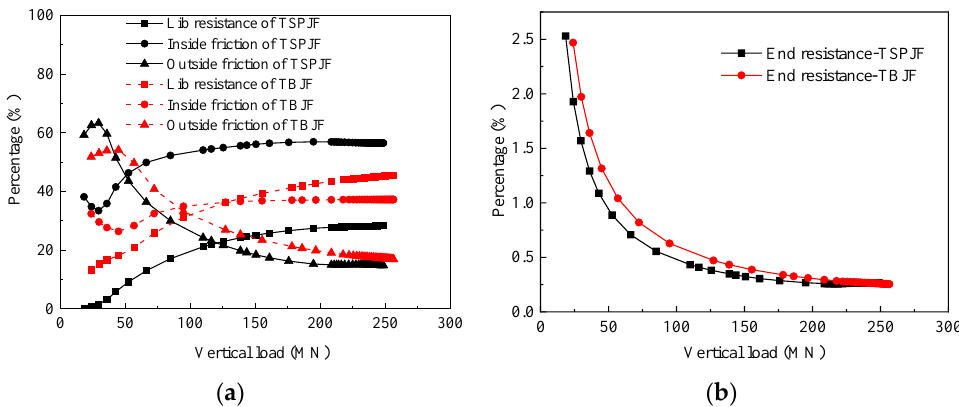
Figure 8. Bearing proportion of each part of the foundations at different vertical loads. ( a ) inside and outside frictional resistance, lid resistance, ( b ) end resistance.